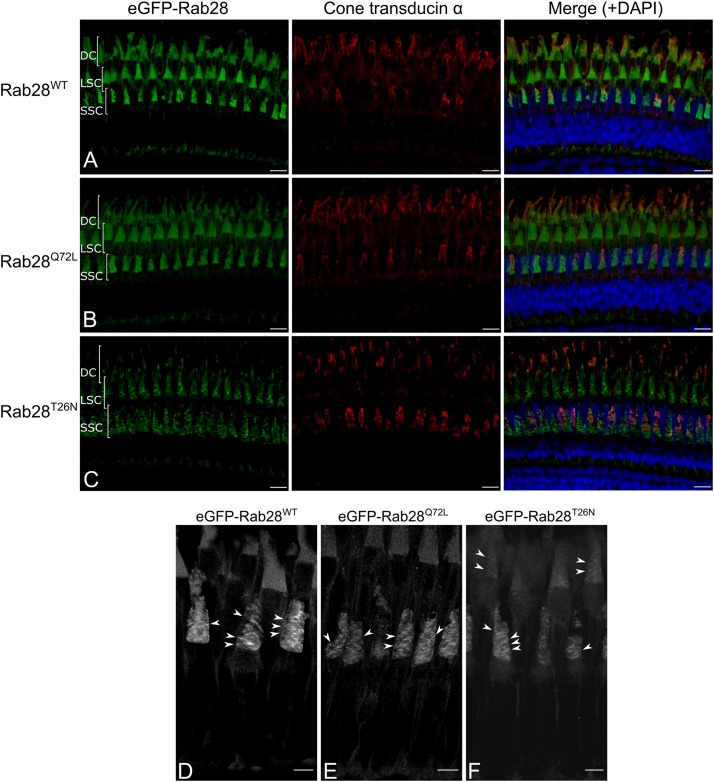
eGFP-Rab28 localization in 1 mpf zebrafish cone photoreceptors. (A–C) Representative confocal z-projections of eGFP-Rab28 localization in 1 mpf zebrafish cones. Cone OS are stained with anti-cone transducin alpha antibody. Each tier of photoreceptors is comprised of different classes of cone. DC: double cones; LSC: long single cones; SSC: short single cones. Scale bars 10 μm. For WT, Q72L and T26N eGFP-Rab28 reporters a total of 13, 11 and 11 retinas across at least six individuals were imaged, respectively. (D–F) Deconvolved, high resolution confocal z-projections of eGFP-Rab28 WT, Q72L and T26N mutant localization in 1 mpf cones. Arrowheads point to discrete bands present throughout the OS. Scale bars 5 μm.